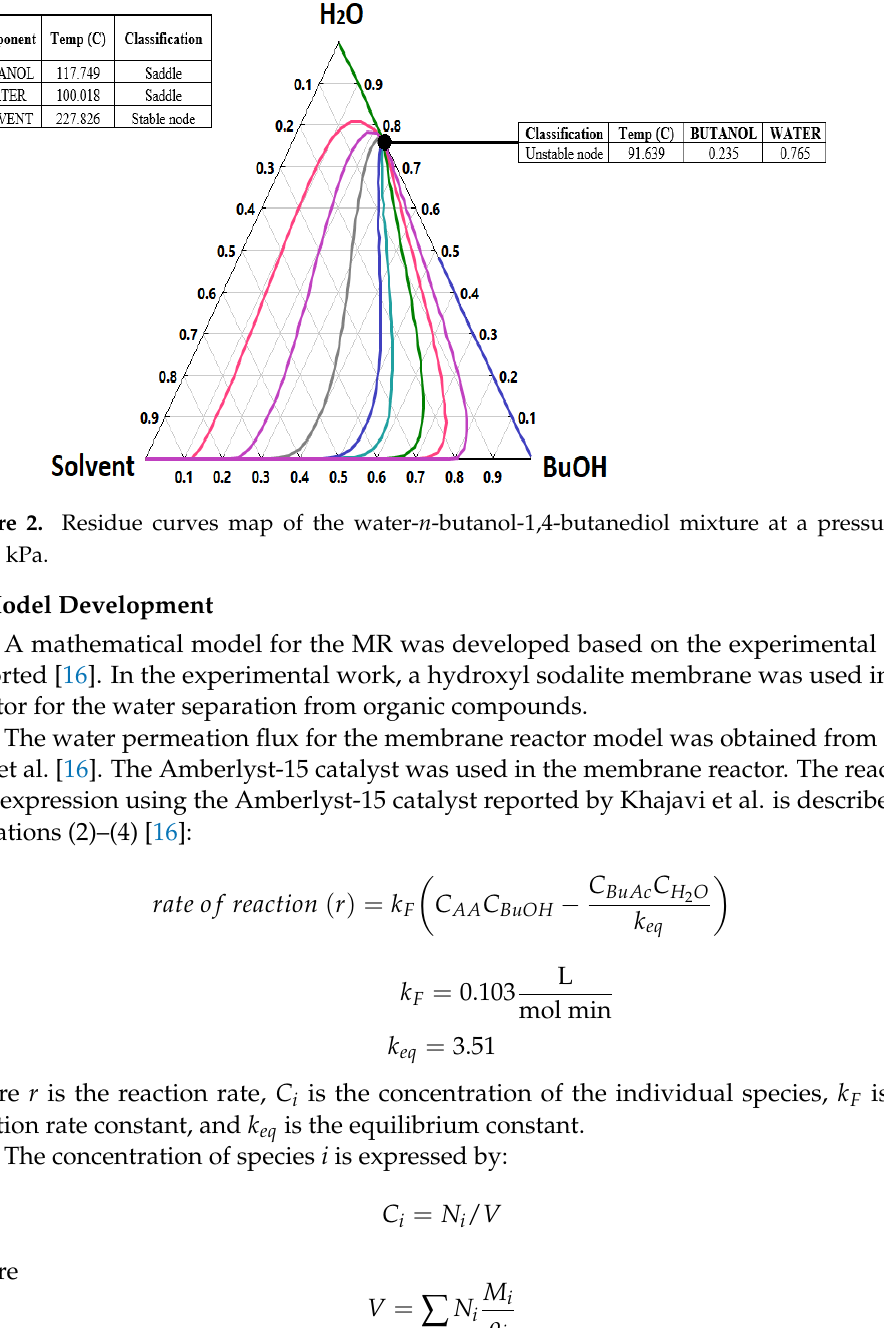
Figure 1. Equilibrium conversion of n -butanol vs. reaction temperature for the esterification reac- tion.